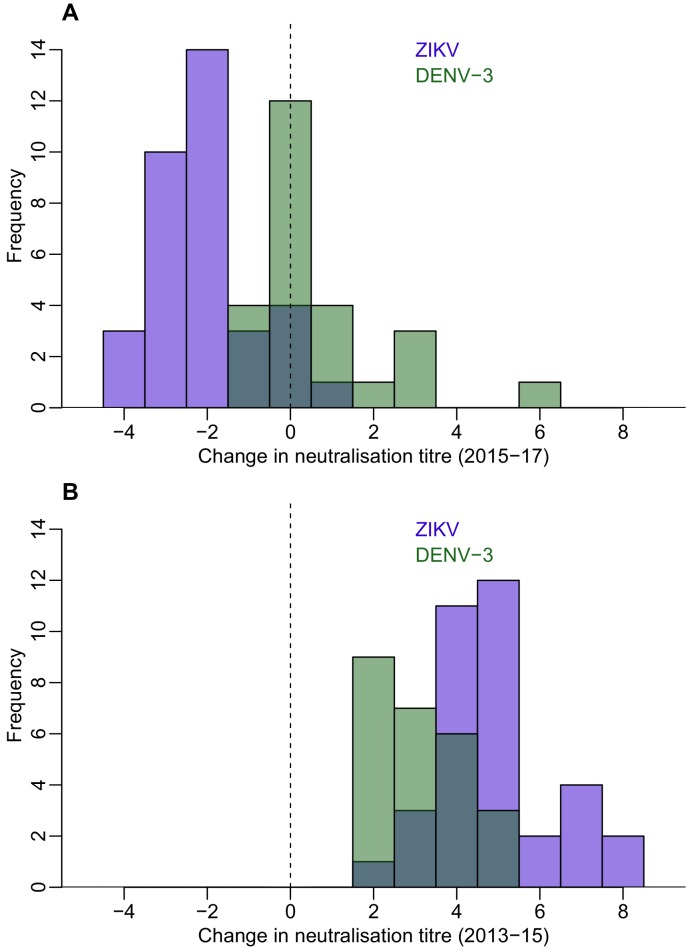
Waning of neutralizing antibody responses against ZIKV and DENV-3 in Fiji for participants who had a four-fold rise between 2013 and 2015.Histogram of change in neutralization assay log titre against DENV-3 (n = 25) and ZIKV (n = 35) between 2015–2017 for individuals who had a rise in log titre of at least two to these respective viruses between 2013–2015. (B) Histogram of change in log titre between 2013–2015 against DENV-3 and ZIKV for individuals who had a rise of at least two during this period.